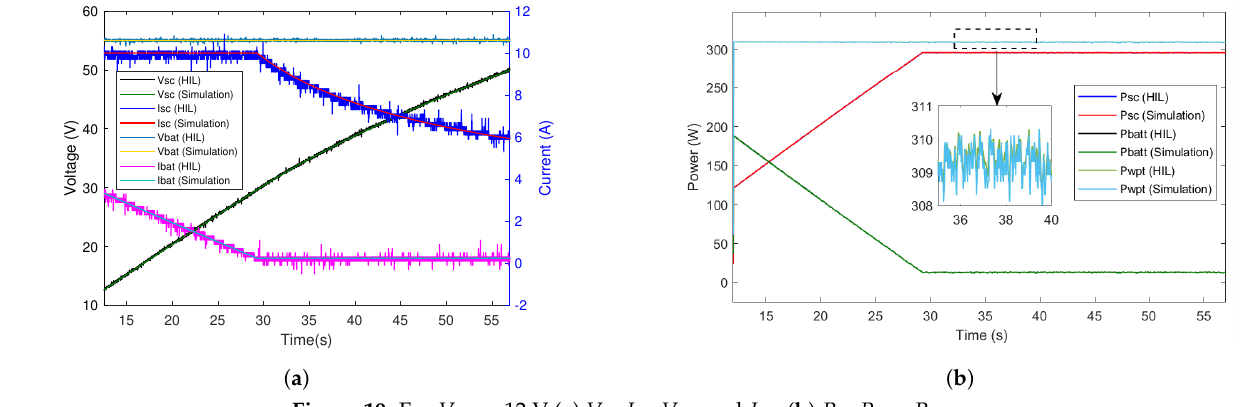
Figure 19. For V sci = 12 V ( a ) V sc , I sc , V bat and I bat ( b ) P sc , P wpt , P bat .